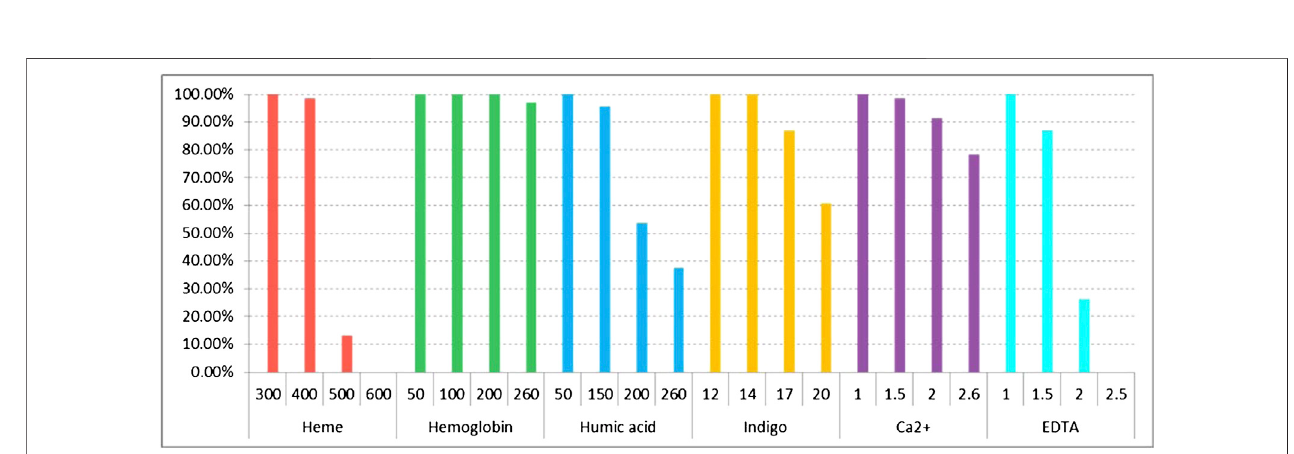
FIGURE 3 | Allele detection rates and peak heights of different quantities of the positive DNA sample 9948 ampli fi ed by the developed kit.